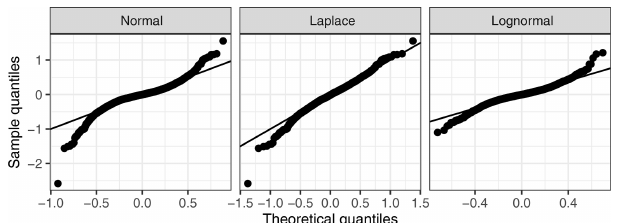
Figure 1. Quantile–quantile plots compare the sample quantiles of observation error to theoretical distribution quantiles. The closer the points to the displayed 1 : 1 line, the better the approximation. Both the Laplace distribution with observations on the original scale and the normal distribution with log-transformed observations (lognor- mal assumption) approximated the sample quantiles better than the normal assumption with observations on the original scale. Here, only data of chamber 2 are shown; the plots of the other chambers look very